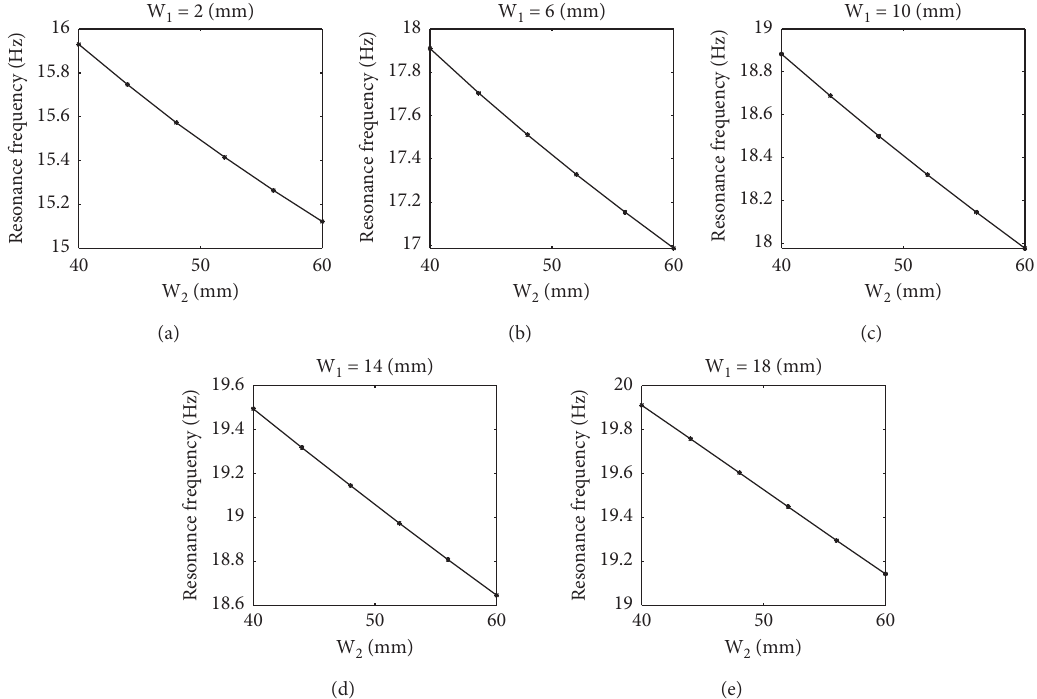
Figure 10: The first resonance frequency of 30 permutations of the two-piece trapezoidal piezoelectric composite bimorph beam (second design). The length of the beam L is 60 mm, the thickness of T piezo is 0.3mm, and the thickness of the brass layer T s is